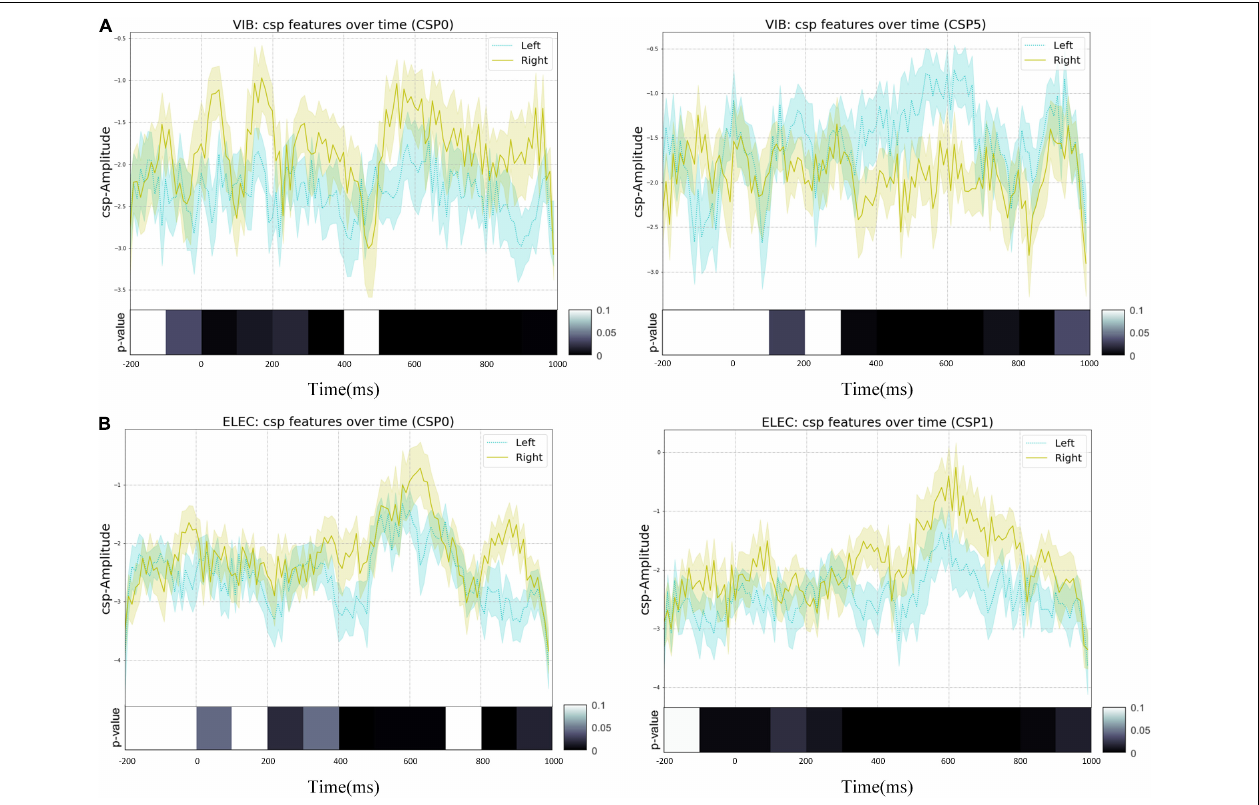
FIGURE 9 | The most representative EEG features over all subjects were transformed by the selected spatial filters of CSP with error-shaded bar (with the standard error), of which one feature point was extracted from the real EEG signals in every 10 ms, and the p -values of left-handed and right-handed feature vectors were calculated in every 10 feature points (i.e., every 100 ms), which was verified by paired t -test: (A) the vibration task, (B) the electrical task.